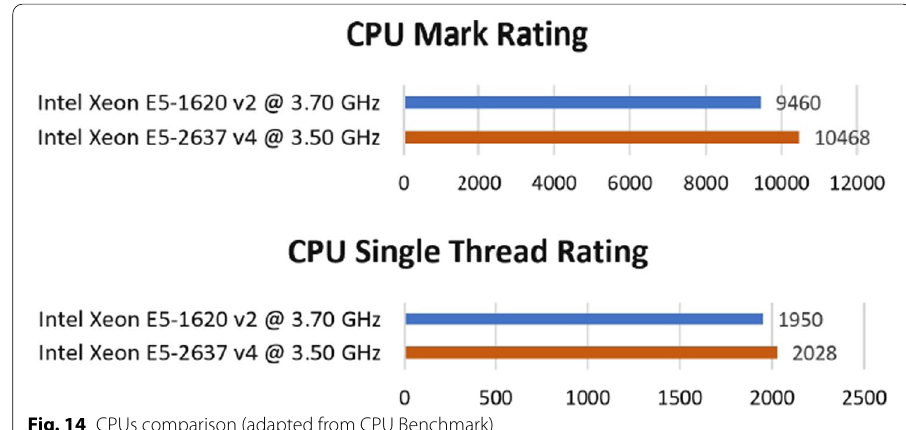
Fig. 14 CPUs comparison (adapted from CPU Benchmark)